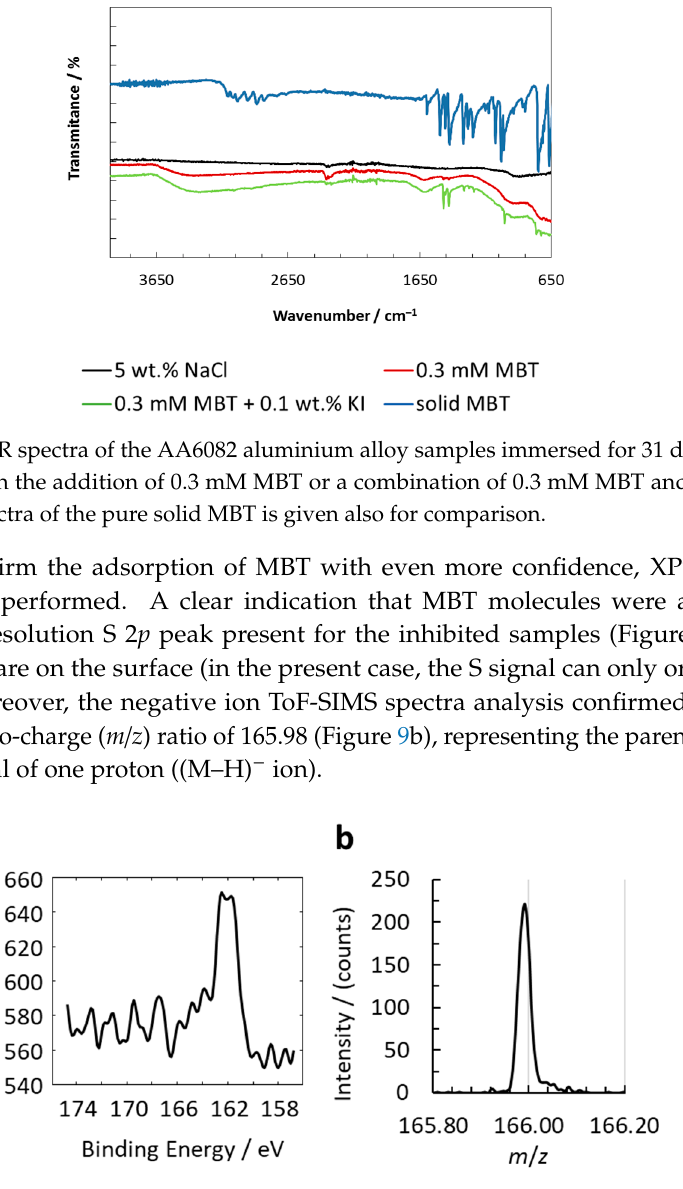
Figure 9. High-resolution ( a ) S 2 p XPS spectra and ( b ) time-of-flight secondary ion mass spectrometry (ToF-SIMS) measurements for the MBT adsorbed on AA6082 aluminium alloy.